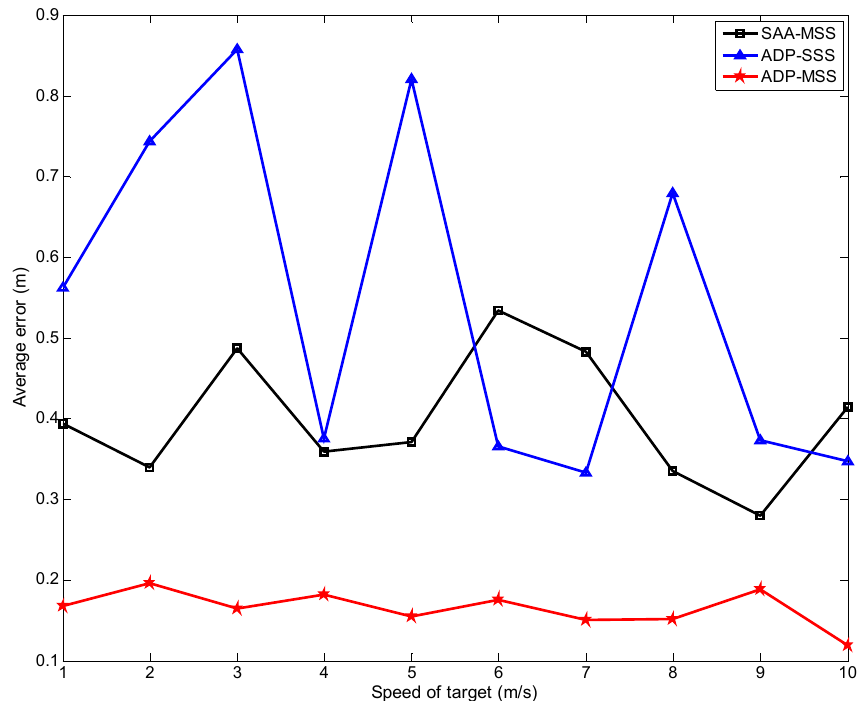
Figure 7. The average tracking error when the target speed changed from 1 m/s to 10 m/s.